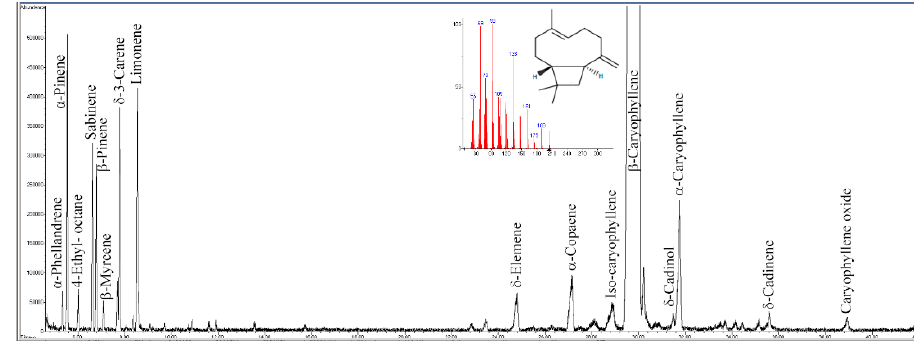
Figure 1. Gas chromatography–mass spectrometry (GC–MS) total ion current gas-chromatogram of